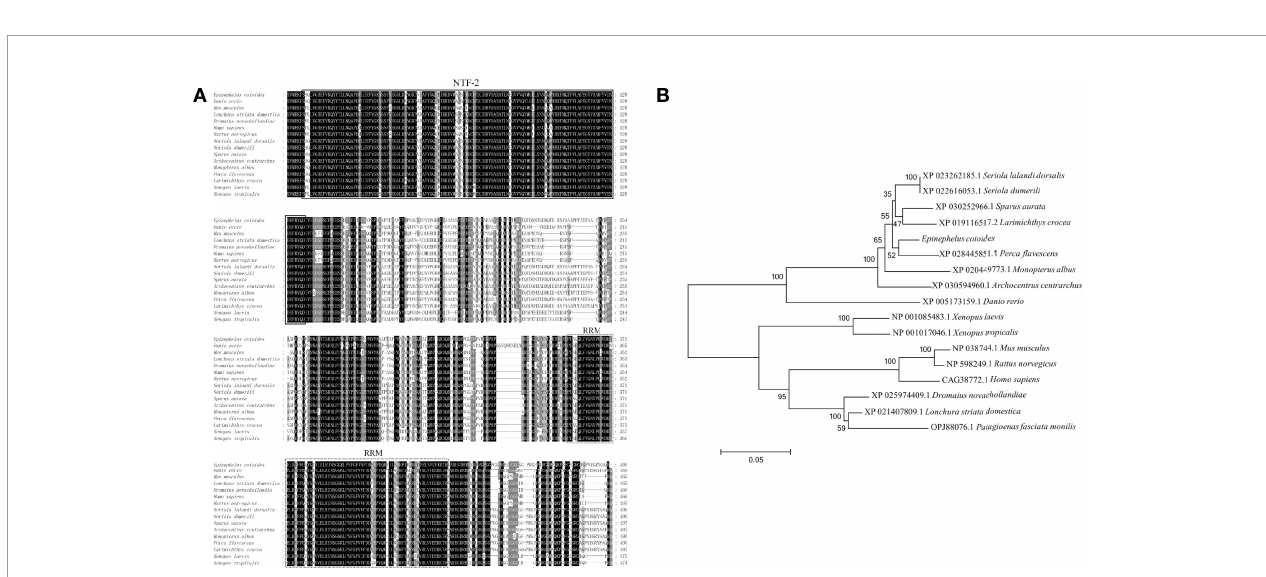
FIGURE 4 | Molecular cloning of grouper EcG3BP1. (A) Nucleotide sequence and inferred amino acid sequence of EcG3BP1. Multiple sequence alignments of EcG3BP1 amino acid sequences with other G3BP1 proteins. The conserved domains NTF2 (at positions 7 – 135) and RRM (at positions 353 – 432) are boxed with solid lines and dotted lines, respectively. The genetic sequence numbers of these species are as follows: Danio rerio , XP_005173159.1; Mus musculus , NP_038744.1; Lonchura striata domestica , XP_021407809.1; Dromaius novaehollandiae , XP_025974409.1; Homo sapiens , CAG38772.1; Rattus norvegicus , NP_598249.1; Seriola lalandi dorsalis , XP_023262185.1; Seriola dumerili , XP_022616053.1; Sparus aurata , XP_030252966.1; Archocentrus centrarchus , XP_030594960.1; Monopterus albus , XP_020449773.1; Perca fl avescens , XP_028445851.1; Larimichthys crocea , XP_019116517.2; Xenopus laevis , NP_001085483.1; Xenopus tropicalis , NP_001017046.1. (B) The phylogenetic tree of EcG3BP1 based on amino acid sequences. The data at each node represent the approval rate repeated 1000 times; the scale represents the number of substitutions per kilobase (same below). The GenBank entry number for each species is listed to the right of the species name.